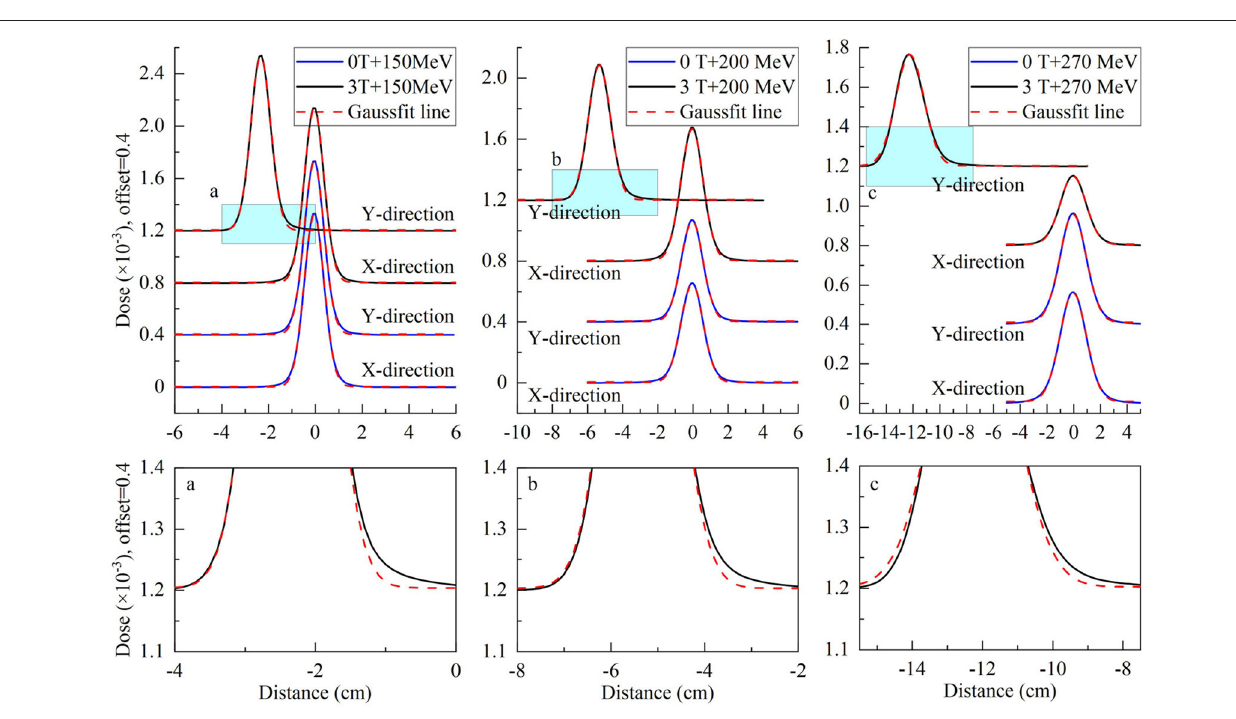
Frontiers in Public Health |